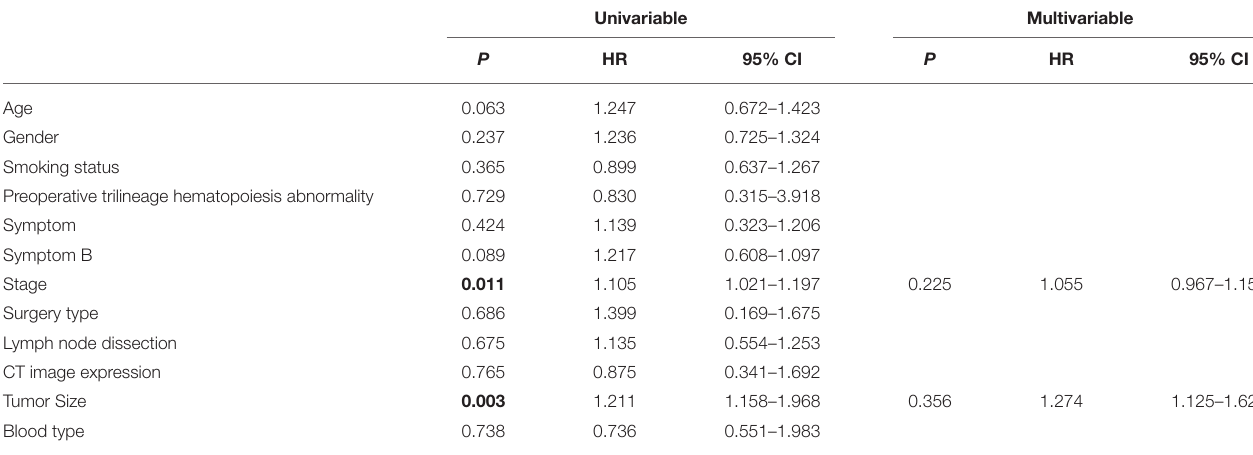
TABLE 2 | Univariable and multivariable analyses for relapse-free survival (RFS) in patients with resected primary pulmonary MALT lymphoma.